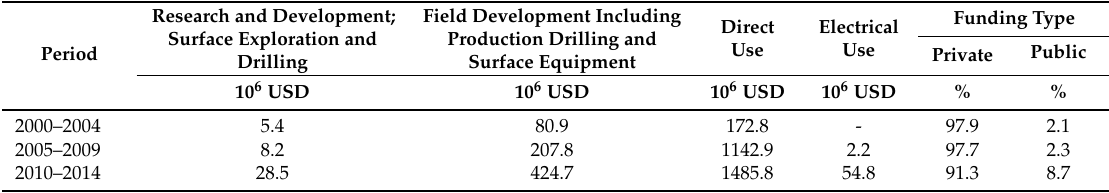
Table 8. Total investments in the geothermal industry